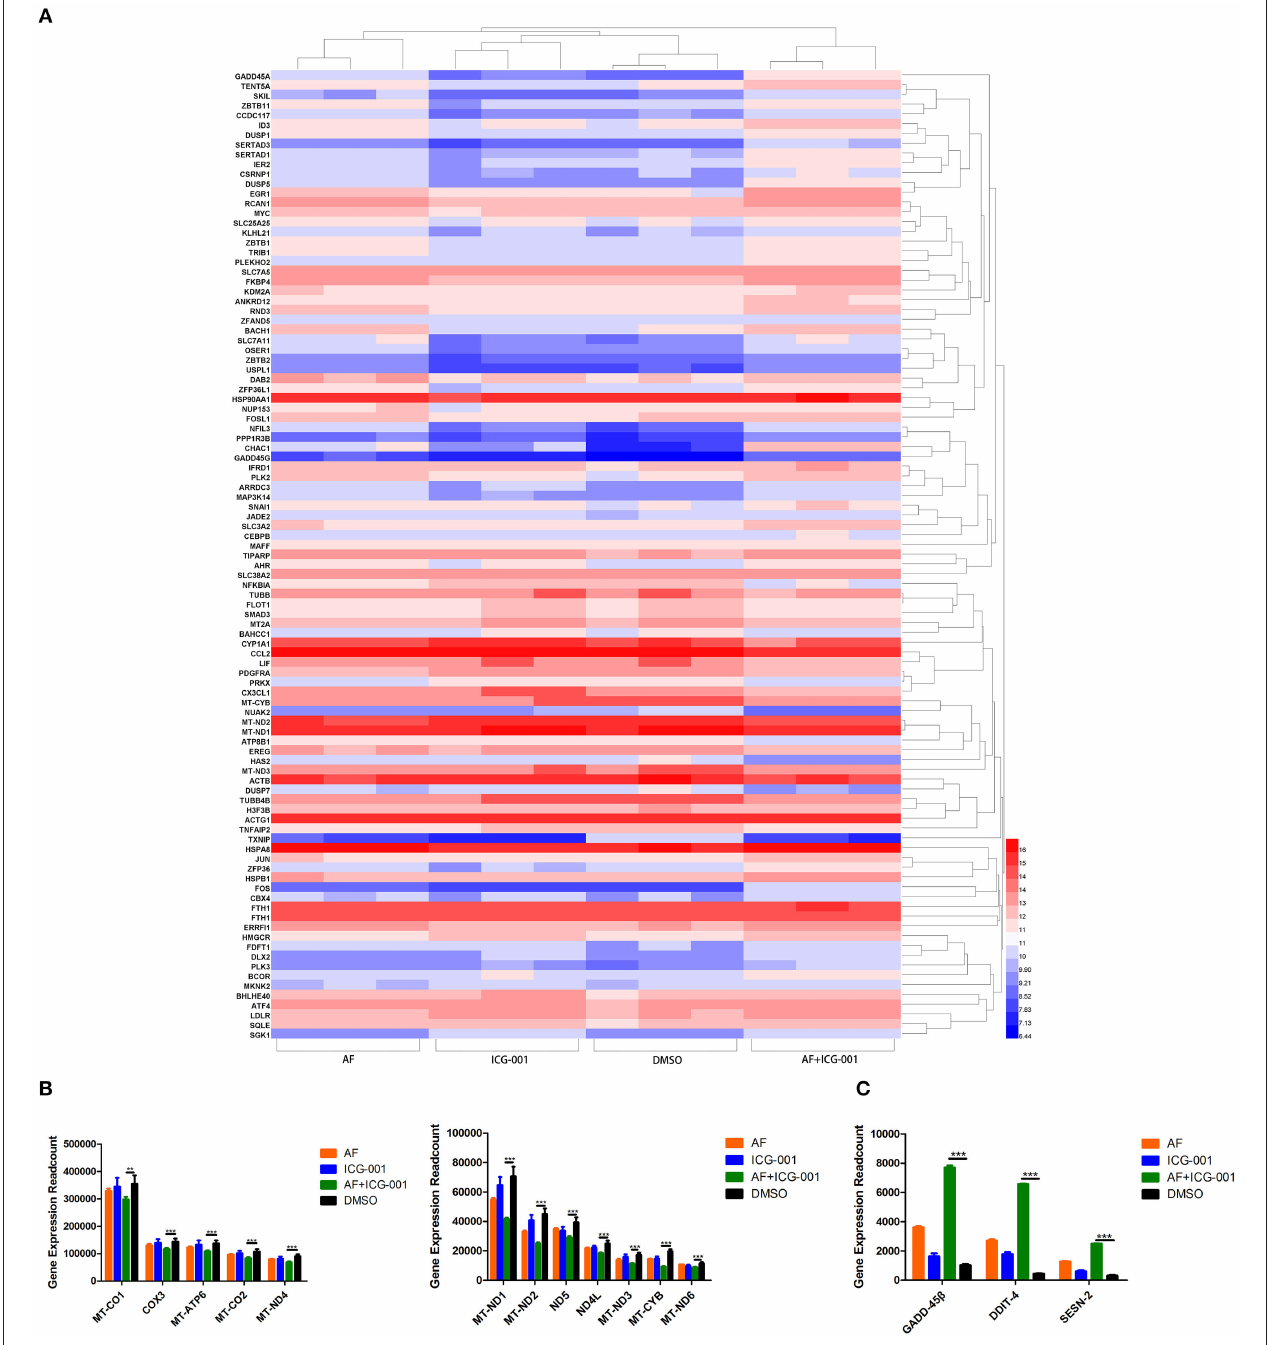
FIGURE 3 | Combination of AF and ICG-001 significantly regulates the expression of redox related genes. (A) The heatmap of 100 most differentially expressed genes of CIPp cells. (B) Read count of the significantly changed redox related genes. (C) Read count of some apoptosis-related genes. Data were representative of three independent experiments. p -values: * p < 0.05; ** p < 0.01; *** p < 0.001.